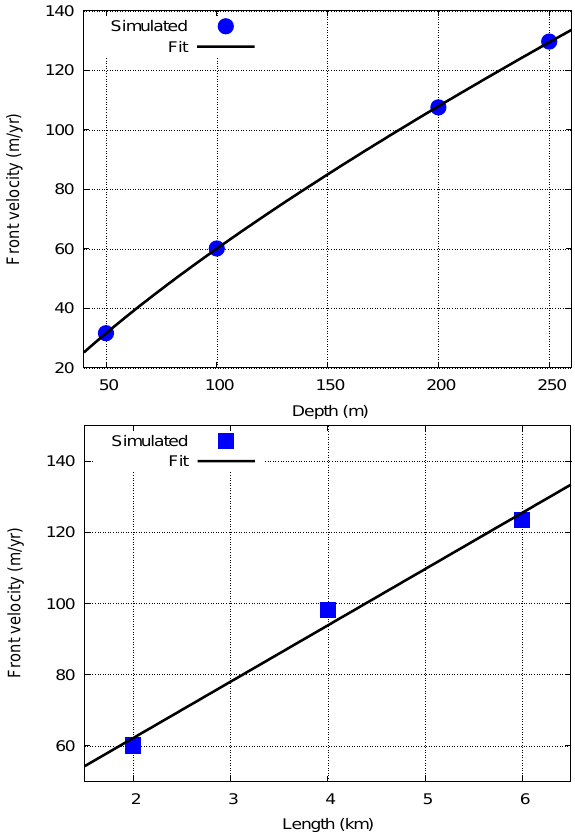
Fig. 7. Top panel: Variation of velocity of the front as a function of thickness H 0 with slope and L 0 kept constant. Bottom panel: Variation of velocity of the front as a function of thickness L 0 with slope and H 0 kept